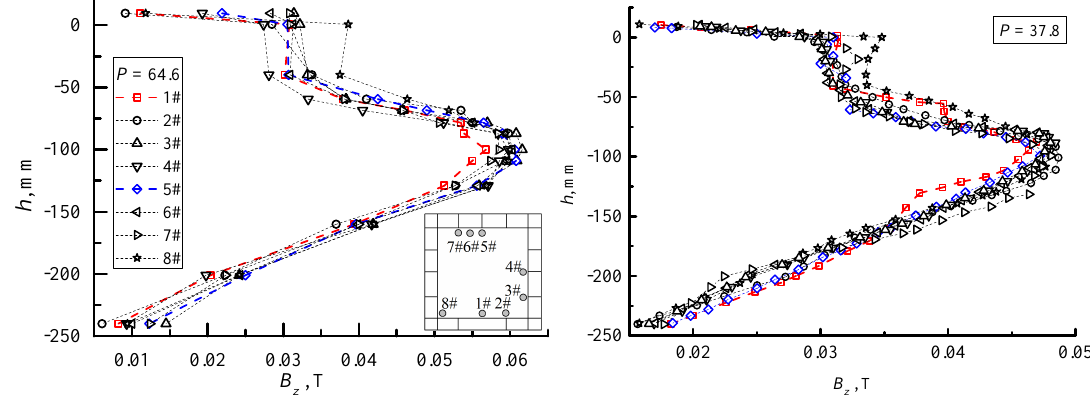
Figure 4. Magnetic flux density distribution along the casting direction at different testing locations for P = 64.6 kW ( left ) and 37.8 kW ( right ) at h m = 0.076 m.